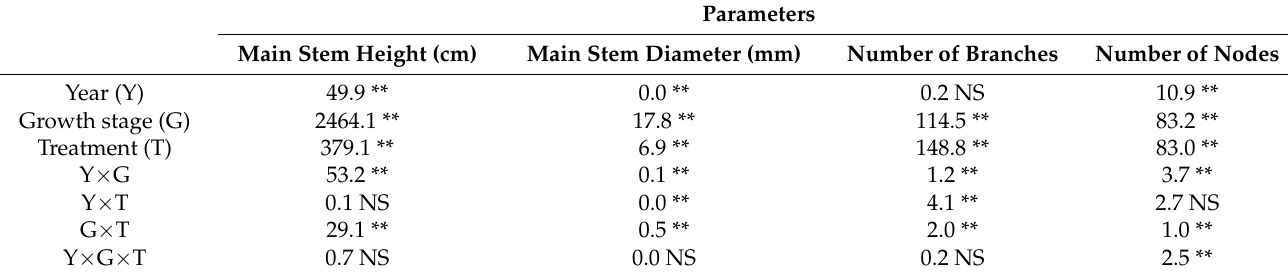
Table 4. Mean square of ANOVA of the effect of year, growth stage, seeding pattern and their interaction on plant growth parameters.